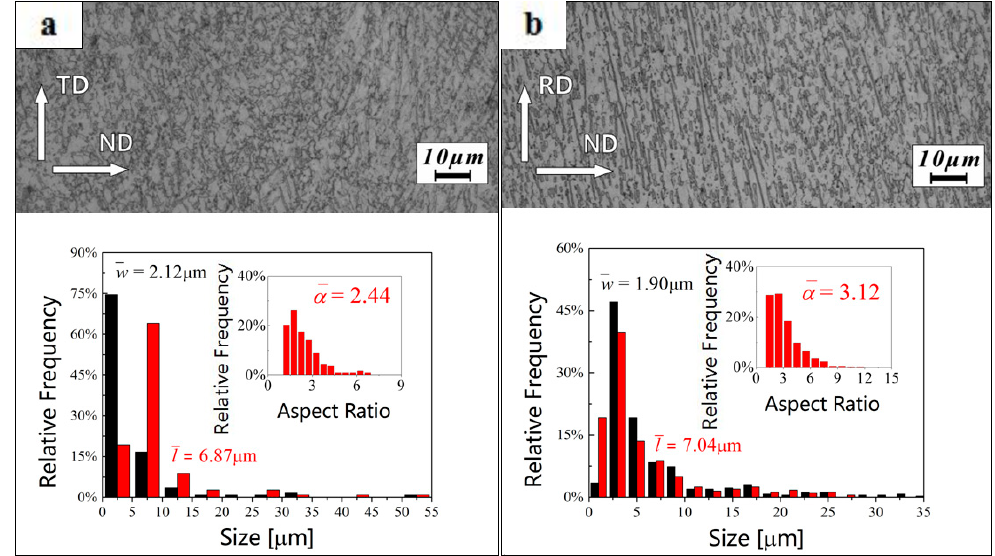
Figure 3. Statistics of the grain size distribution in the lamellar α phase and the microstructure of hot-rolled β 20C observed from the ( a ) rolling direction (RD) and ( b ) transverse direction (TD).